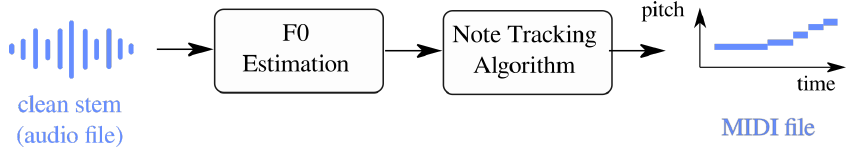
Figure 1. General block diagram of the first method described in this